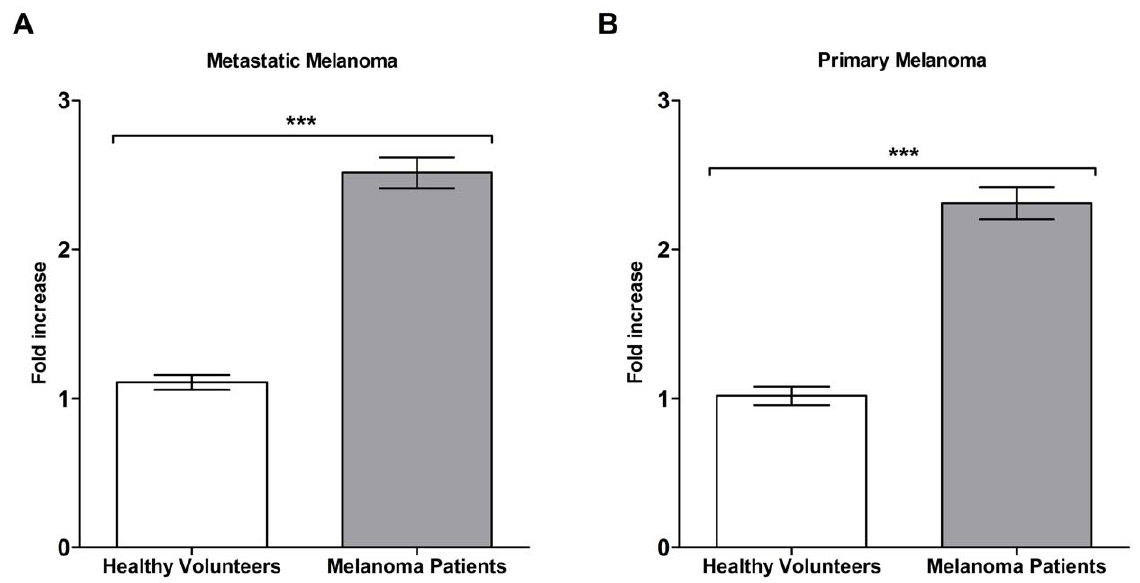
Figure 2. The reactivity of antibodies derived from melanoma patient B cells to primary and metastatic melanoma cells is compared to healthy volunteers. B cell cultures from melanoma patients secreted antibodies that were significantly more reactive against melanoma cell lines compared to healthy volunteers using the cell-based ELISA. Mean reactivity of antibody cultures (n=600) from 10 melanoma patients to A-375 metastatic melanoma cells (A) and WM-115 primary melanoma cells (B), was compared to 10 healthy volunteer cultures (n=600) ( P , 0.0001). Fold increase values represent the optical density of each B cell culture relative to the mean optical density of a negative control human IgG antibody. *** = P , 0.001. Error bars in figures represent 95% confidence intervals.